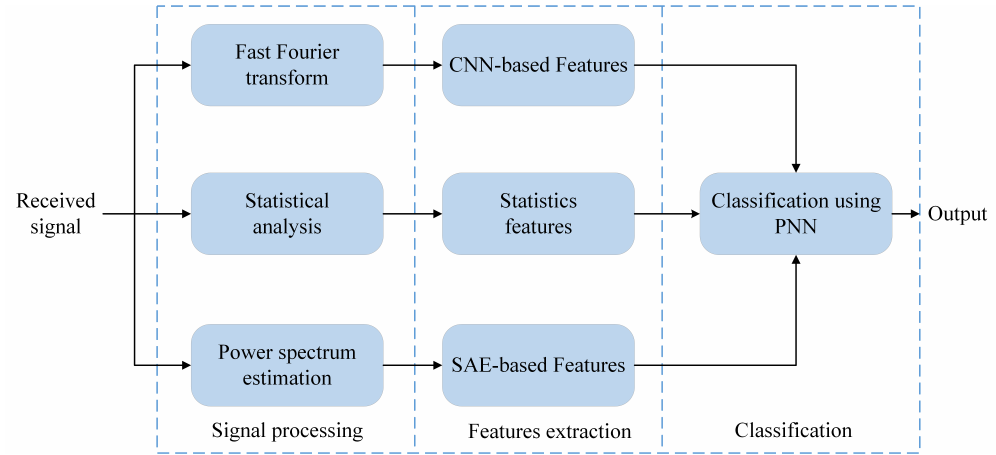
Figure 1. Block diagram of proposed scheme.